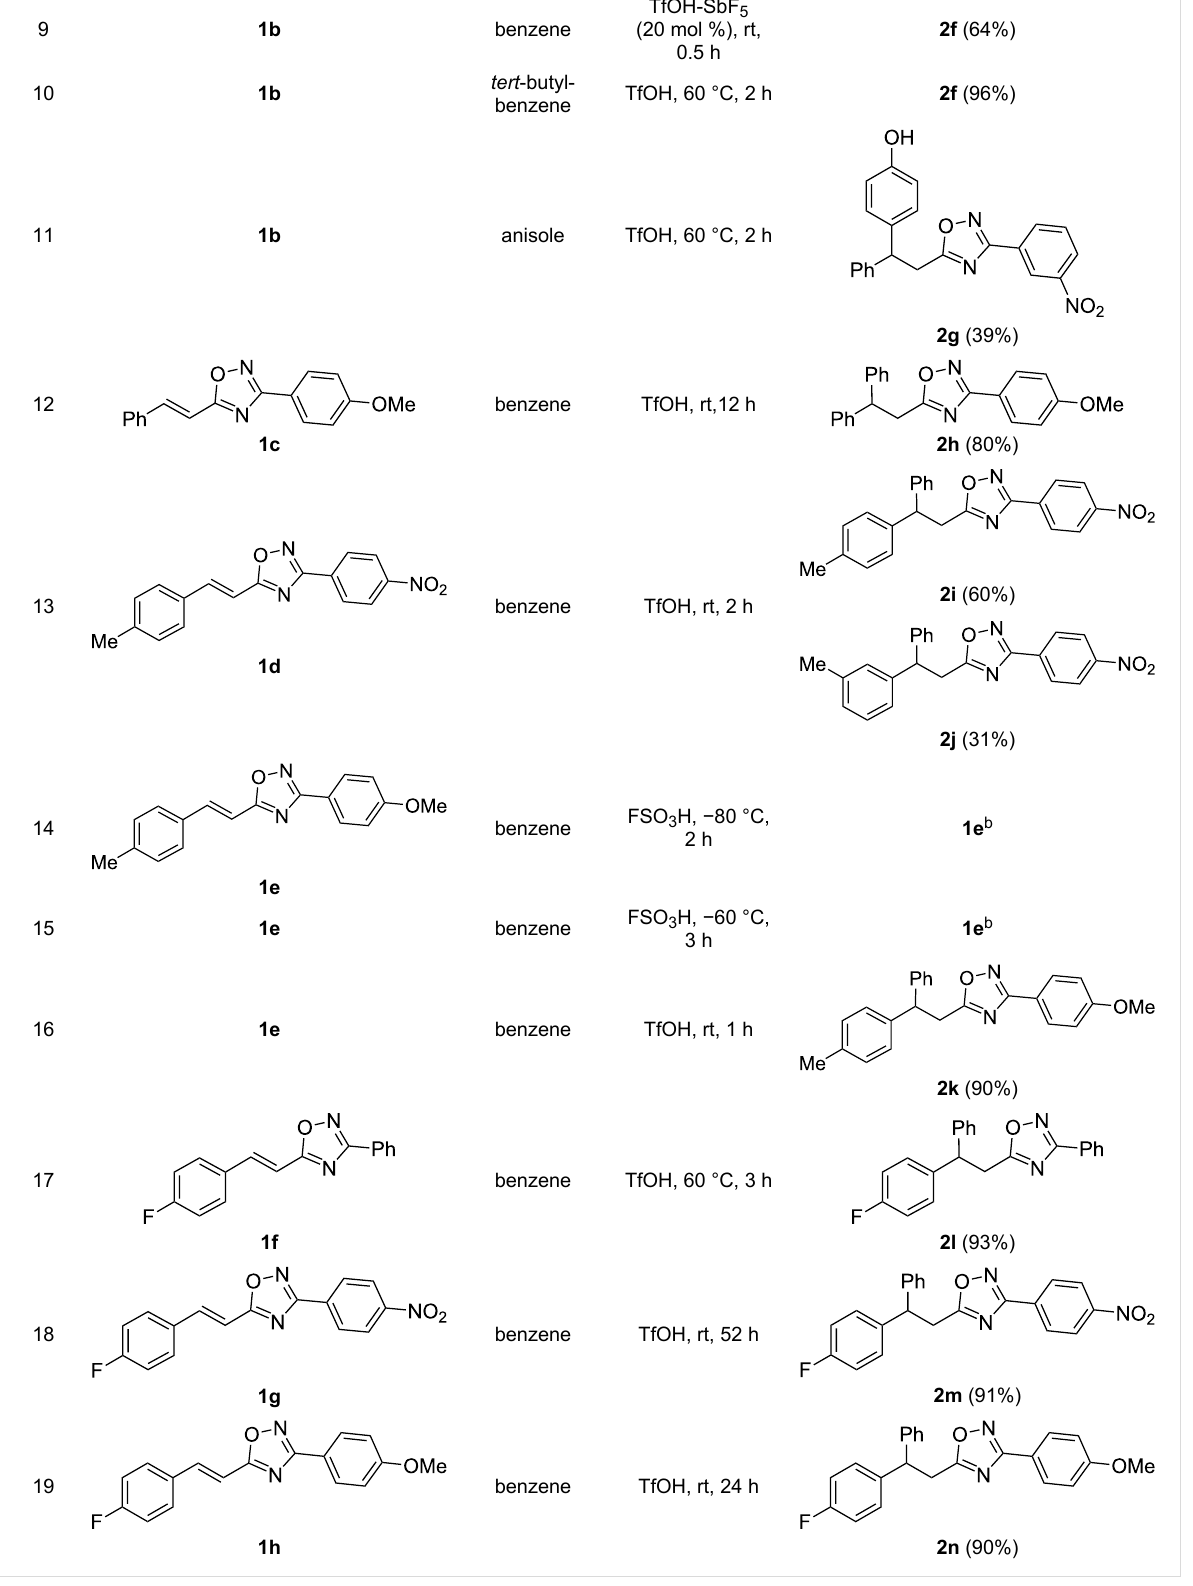
Table 2: Hydroarylation of oxadiazoles 1a–n with arenes under superelectrophilic activation leading to compounds 2a–za .